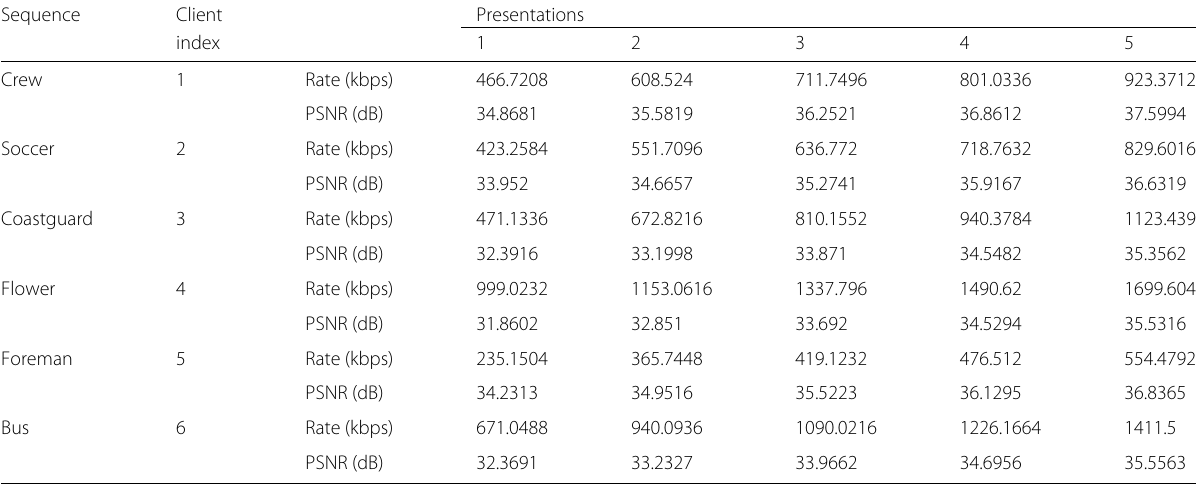
Table 6 The encoding information of different video sequences